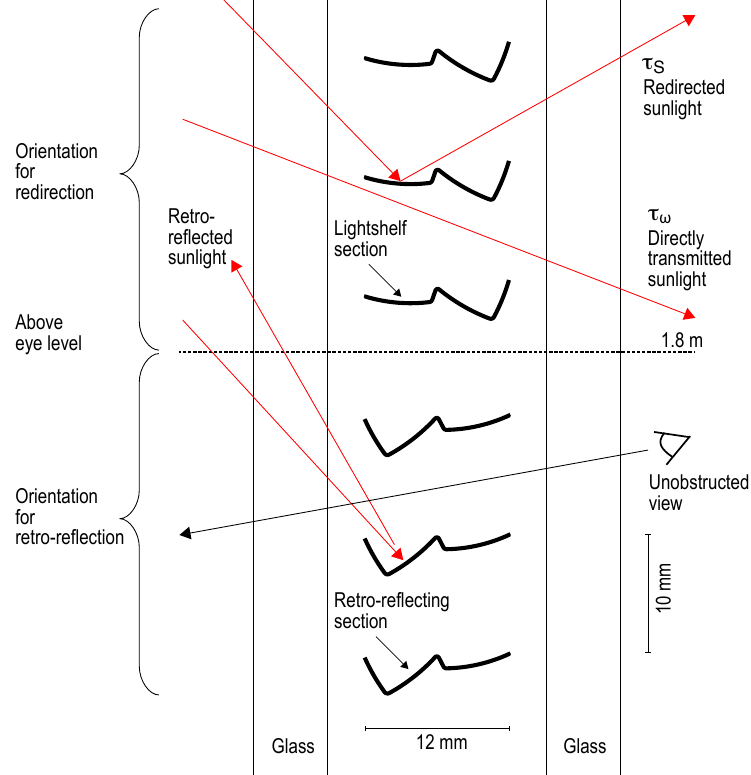
Figure 1. Geometry and optical mechanisms of the DRC (patented by H. Köster). The orientation above eye level is assessed in this